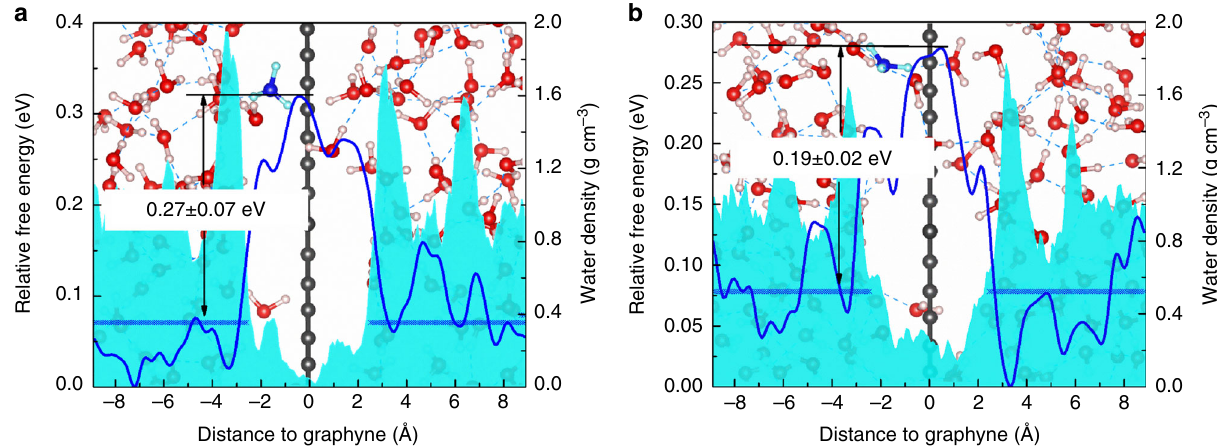
Fig. 5 Free energy pro fi les of hydronium ion and density pro fi les of water. a graphyne ( n = 3) b graphyne ( n = 4). The background shows the initial geometries of the simulation system